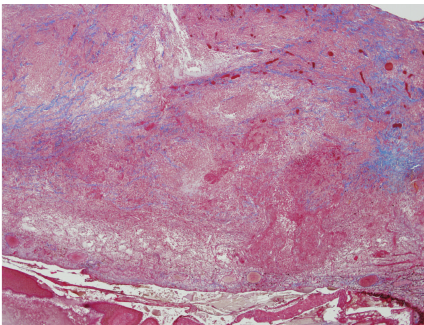
Figure 7: Sclera at the limbus. In this Masson trichrome stained section, there is marked separation of collagenous stroma (blue) by the eosinophilic cellular infiltrate. The collagen is not